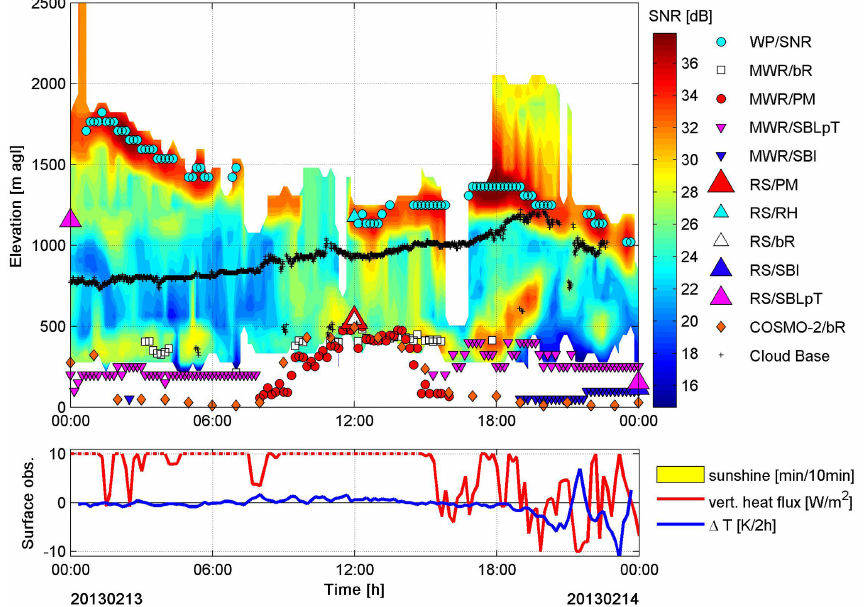
Figure 5. Example of cloudy-CBL detection under cloudy conditions in winter (14 February 2013) plotted on WP/SNR signal as background. For symbol description see Fig. 4. Table 2. Linear regression of PBL height detected by θ v as a function of the PBL height detection by θ : slope, intercept, coefficient of determination between the data and the fit ( R 2 ), coefficient of determination between the data and the 1 : 1 line ( R 2 of the x − y difference (RMS), median of the difference between x and y coordinates (median bias) and the number of considered data ( N ). The results are given for PM and bR methods applied to RS and MWR data. Instrument/ Slope Intercept R